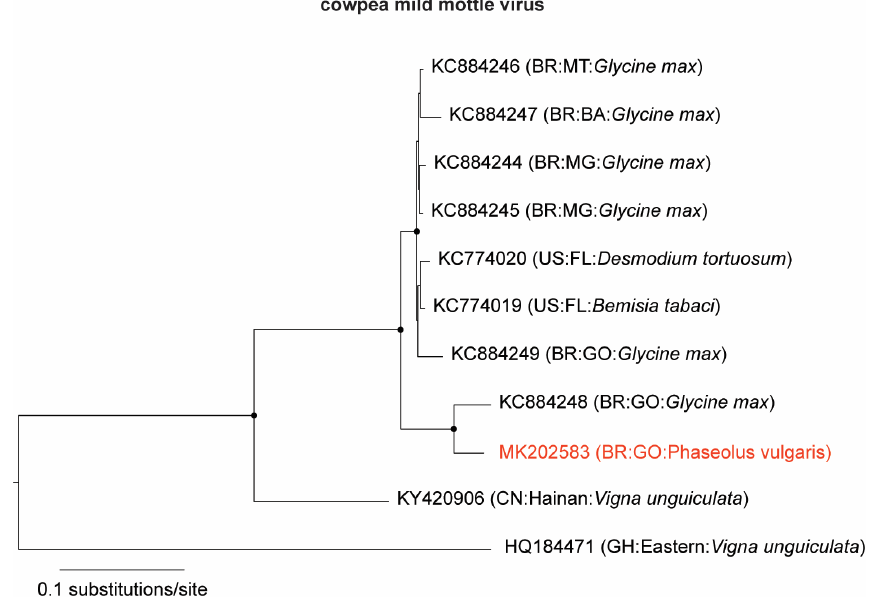
Figure 1. Maximum likelihood tree of cowpea mild mottle virus (CPMMV) isolates. The tree was inferred using an alignment of the complete genomes of CPMMV available in GenBank. The tree is midpoint rooted for purposes of clarity, and the nodes indicated by a black dot have Shimodaira–Hasegawa-like branch test ≥ 0.9. The newly sequenced CPMMV (BR:GO:14) isolate is highlighted in